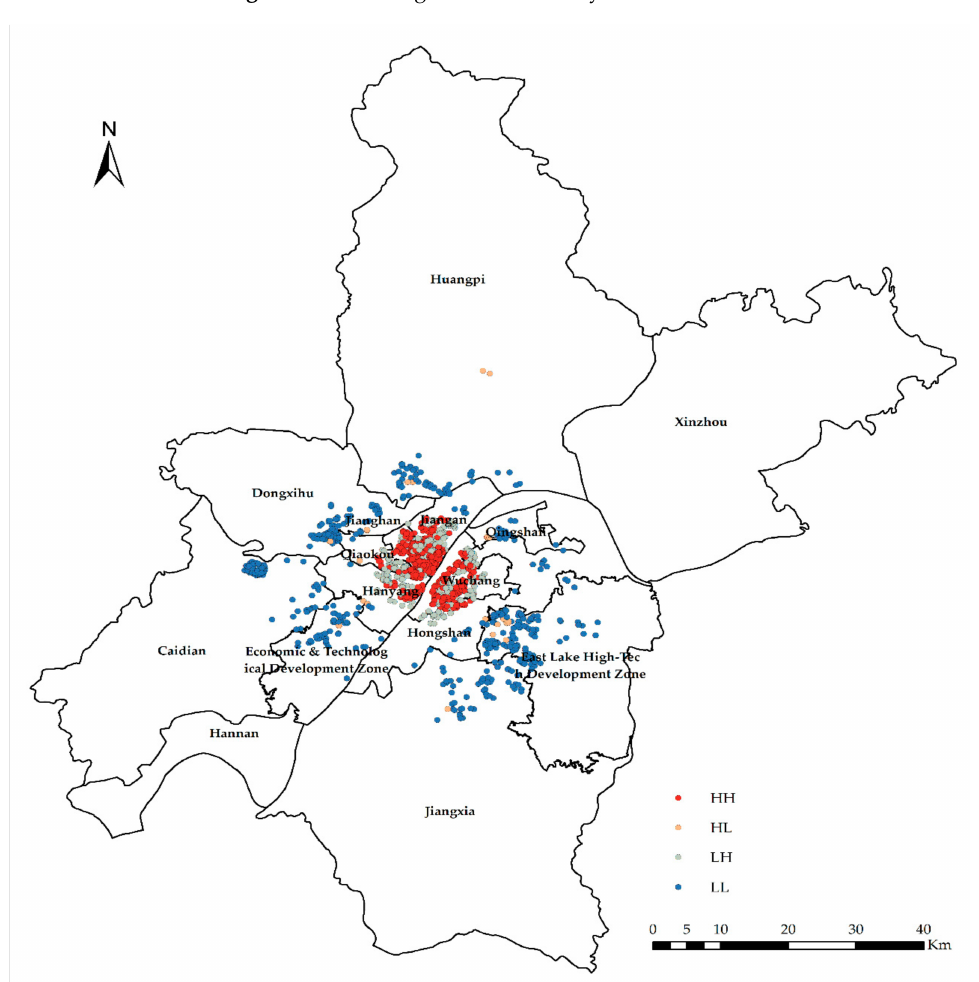
Figure 9. Clustering and outlier type of the